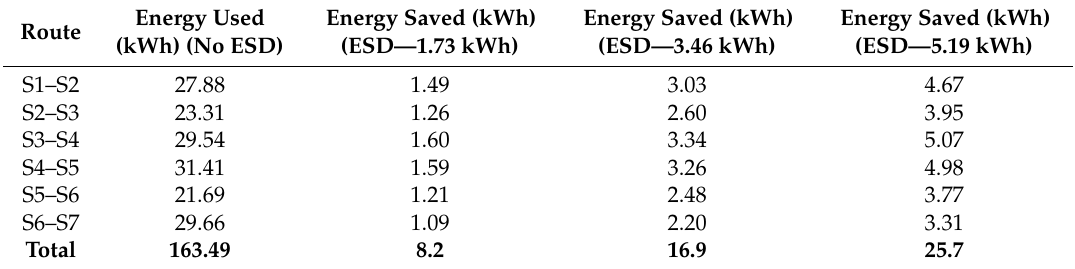
Figure 8. Simulation results for Ea, Ed—energy during acceleration and braking respectively; Sa, Sd—distance travelled during acceleration and braking respectively; ya, yd—route velocity optimization parameters (33): ( a ) velocity limitation parameter for acceleration, ( b ) velocity limitation parameter for braking. The energy required to accelerate a described train from 0 km/h to 90 km/h equals 30.8 kWh, Figure 8a. From Figure 8b it may be observed that the highest braking energy, 19.8 kWh, is achieved for a maximum speed of 90 km/h. It can be concluded that an important parameter to size the ESD are speed limits which affect the available train braking energy. Table 6 presents assumed train operation parameters calculated for 1 year. Table 6. Assumed train operation for a calendar year. Time